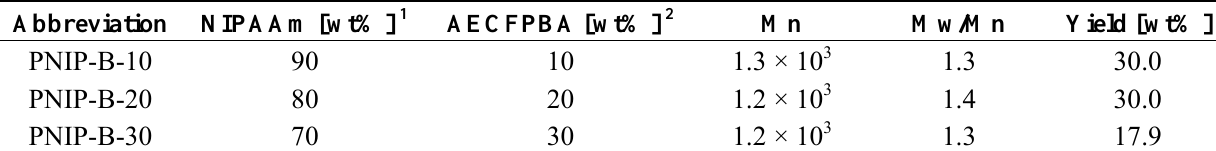
Table 1. Preparation and characterization of PBA containing